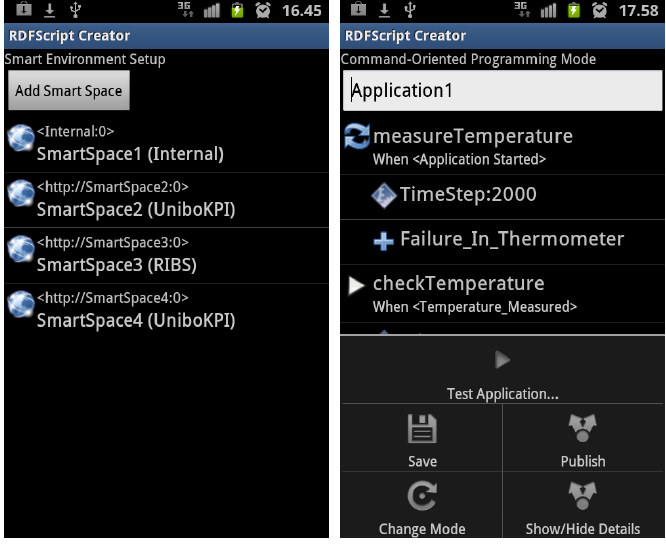
Figure 9. The cross-smart space application is executed in the configured smart environment.